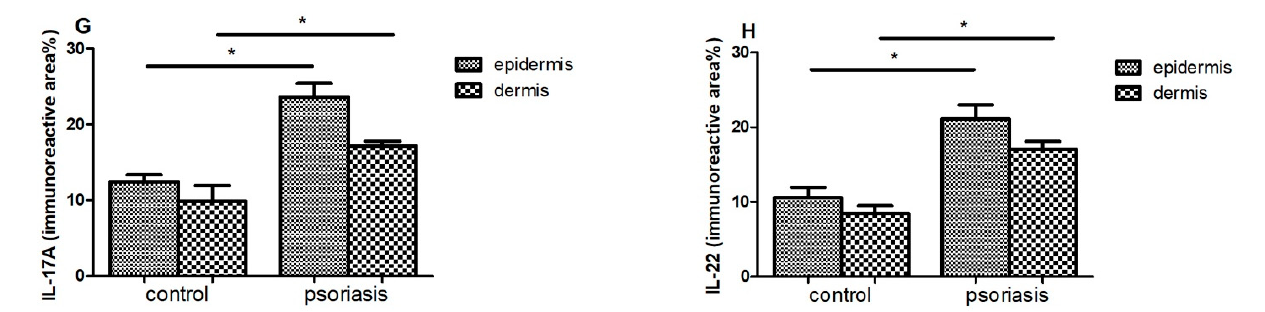
Figure 3. Immunoreactive area (means ± SEM) of ( A ) CD8; ( B ) CD4; ( C ) CD103; ( D ) CD49; ( E ) CD69; ( F ) CXCR6; ( G ) IL-17A; ( H ) IL-22 in lesional skin ( n = 32, dermis and epidermis) in comparison with healthy control ( n = 10, dermis and epidermis). Bars with asterisks are significantly different ( p < 0.05, Mann–Whitney U test).